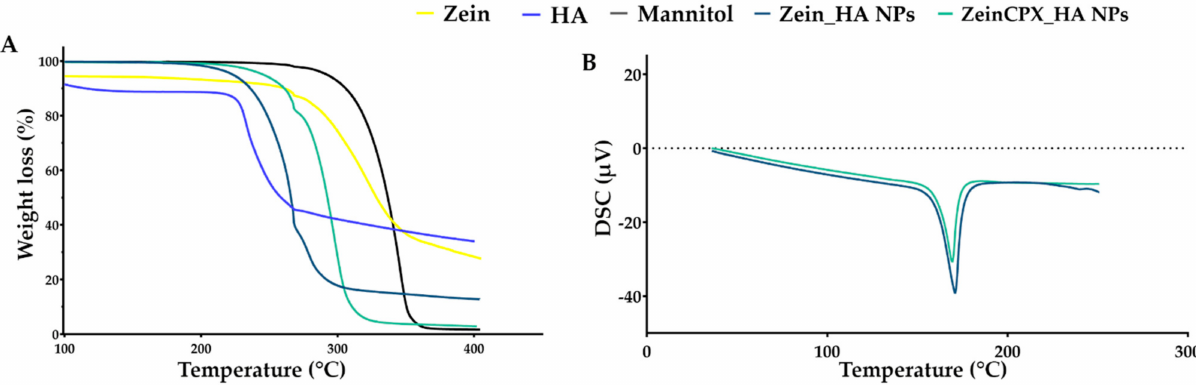
Figure 3. TGA ( A ) and DSC ( B ) analysis of the raw materials (zein, HA and mannitol), Zein_HA NPs and ZeinCPX_HA